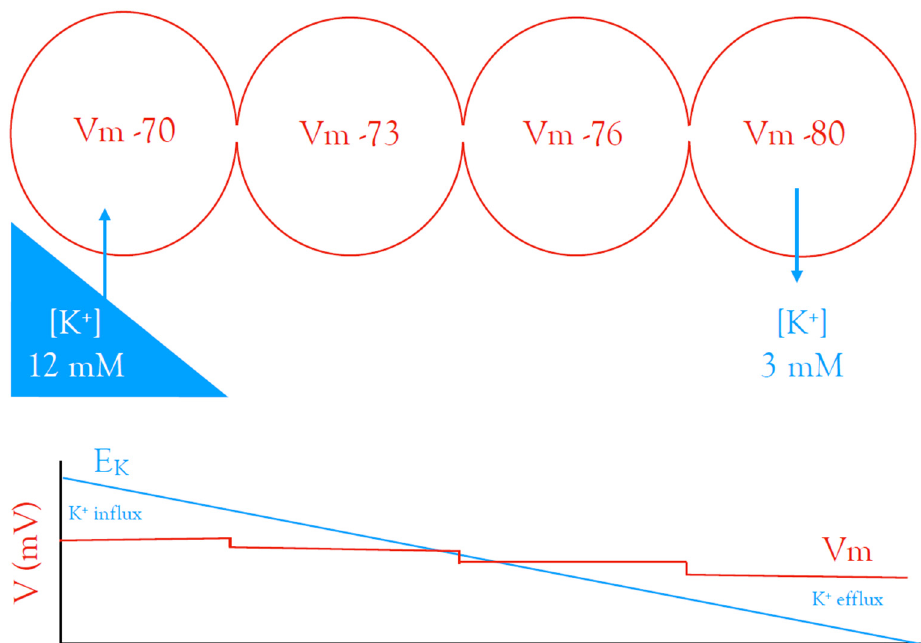
Figure 8. Spatial buffering throughout the astrocyte syncytium. Blue is associated with E K and red with membrane potential (Vm). Localised elevations in [K + ] o resulting from neuronal activity (left middle—blue triangle) lead to K + influx into nearby astrocytes, causing Vm depolarisation towards E K . The Vm does not reach E K as the astrocyte is connected to neighbouring astrocytes, which display a more hyperpolarised Vm. This disparity between Vm versus E K leads to K + influx into astrocytes, which sets up a current through the syncytium, where in more distant astrocytes, the polarity of the difference between Vm and E K switches, leading to K + efflux from the astrocytes (adapted from Ref. [23]).